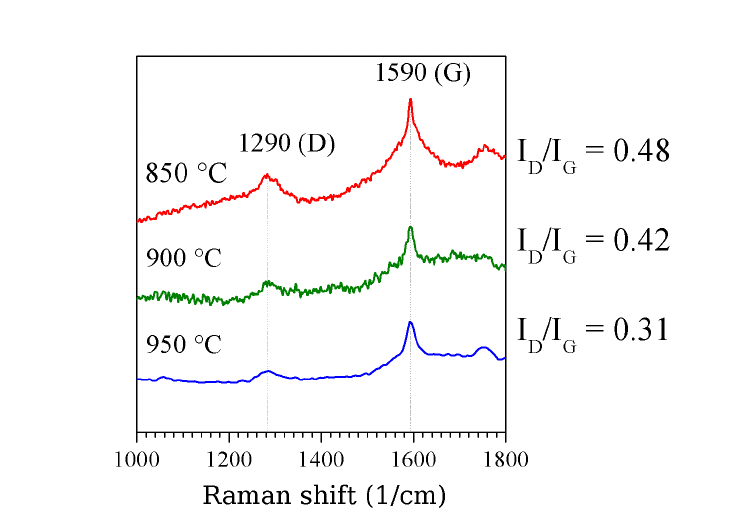
Figure 16. Raman spectra of Fe-CNT [12]. The crystallinity of the CNT structure increases with increasing reaction temperature. The intensity of the D-band decreases relatively to the intensity of the